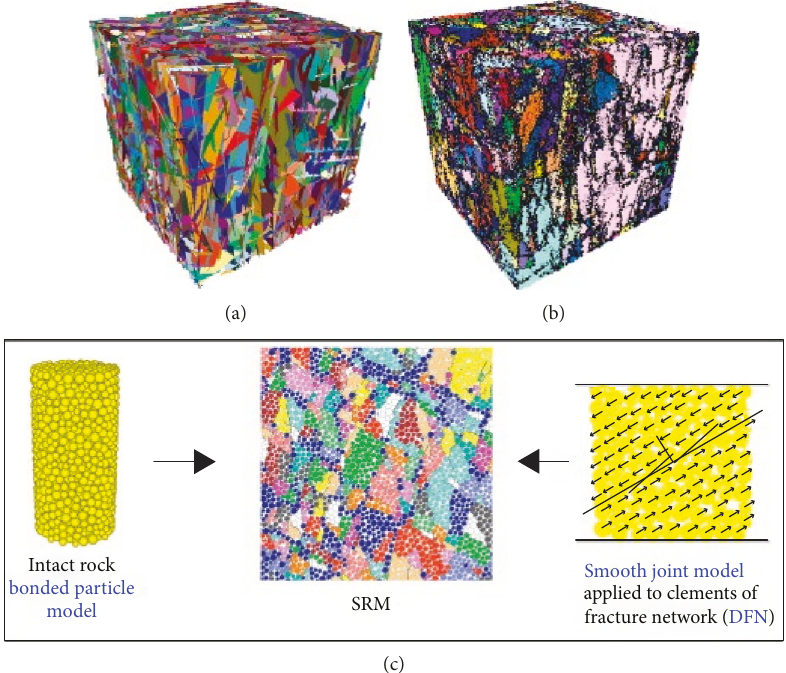
Figure 15: The synthetic rock mass (SRM) model [149]. (a) The discrete fracture network (DFN) model, (b) the corresponding synthetic rock mass sample, and (c) synthetic rock mass basic